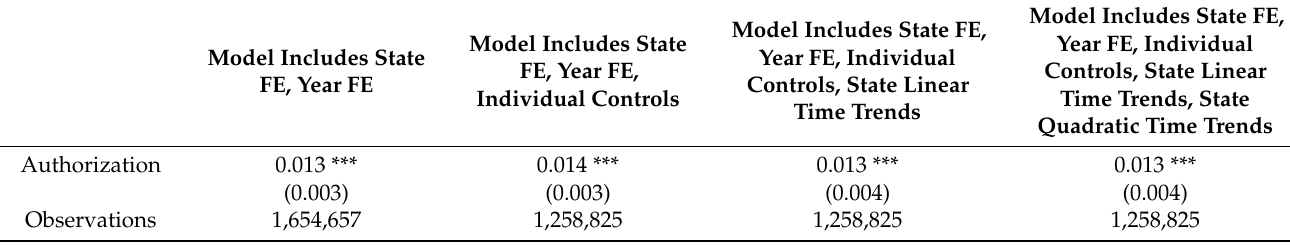
Table 2. Impact of explicit vaccination authority for pharmacists on influenza vaccine uptake rate for adults age 65+,